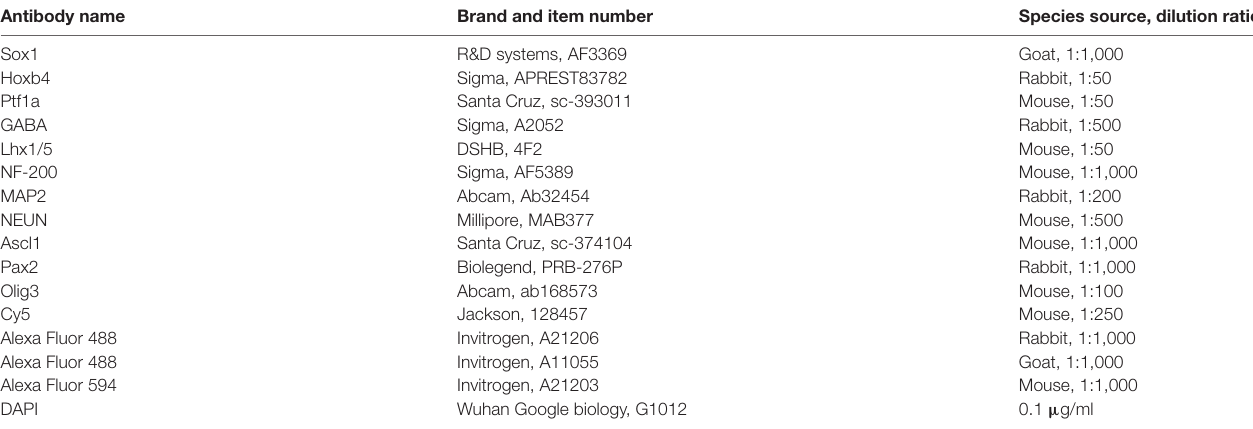
TABLE 1 | Antibodies and fluorochromes employed in this